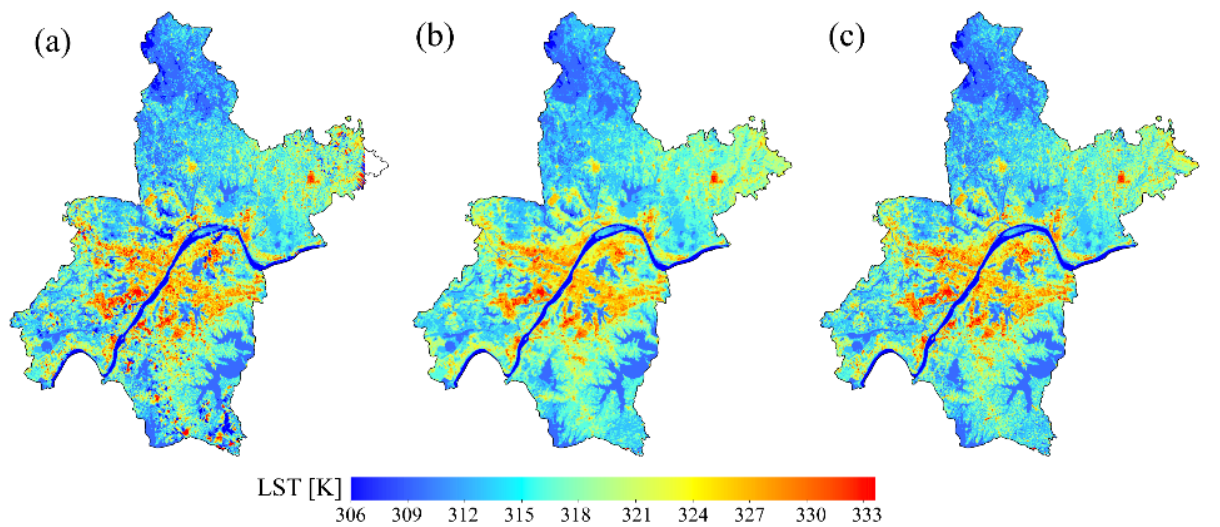
Figure 5. Performances of the predictions and the original LST: ( a ) SI LST, ( b ) RF regression LST, and ( c ) SFRFR LST.